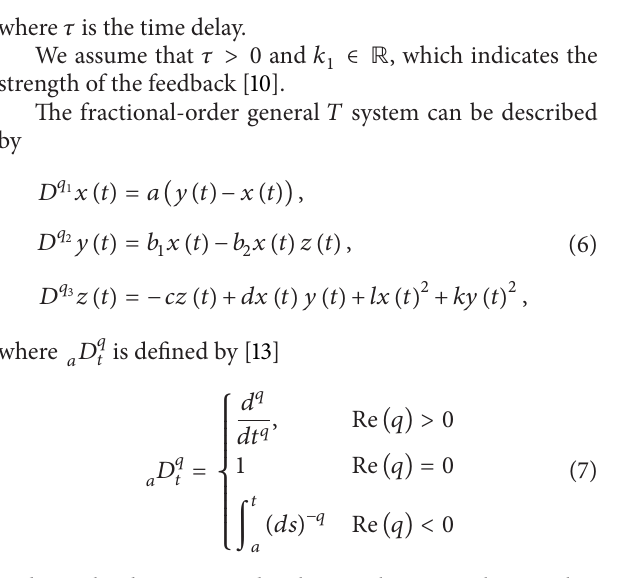
Figure 2: Dynamics of Lyapunov exponents of (4) with 𝑎 = 10, 𝑏 1 = 40, 𝑏 2 = 1, 𝑐 = 2 . 5, 𝑑 = 3, 𝑙 = 0 . 9, and 𝑘 =